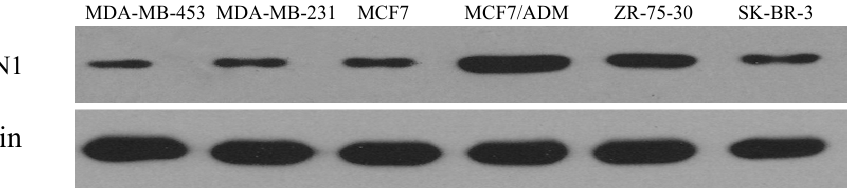
Figure 2. Expression of CIAPIN1 protein in breast cancer cell lines by Western blot.